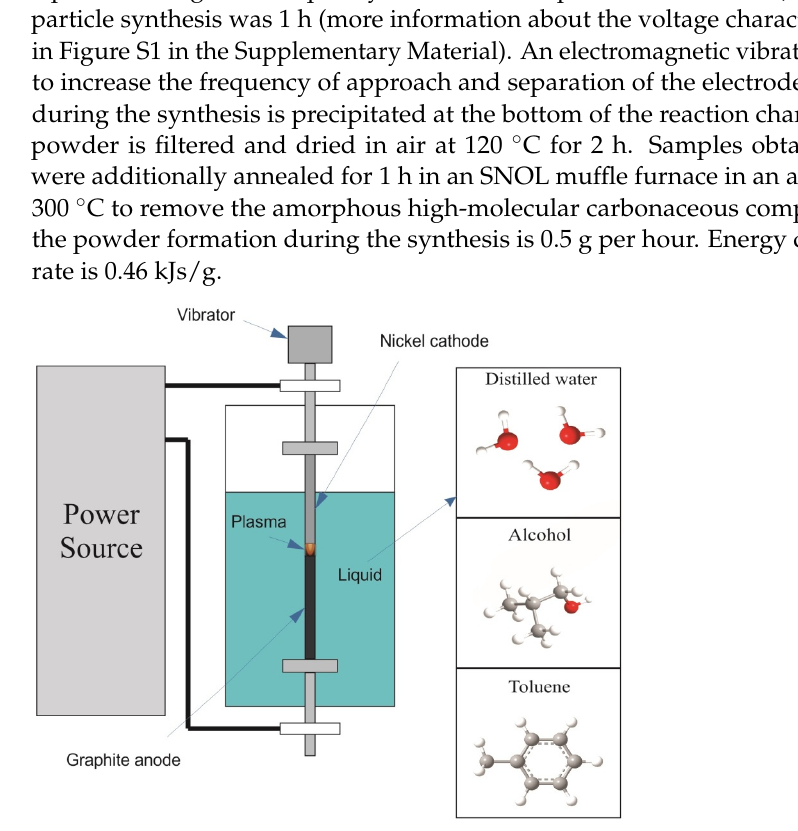
Figure 1. Experimental setup of arc discharge in liquid